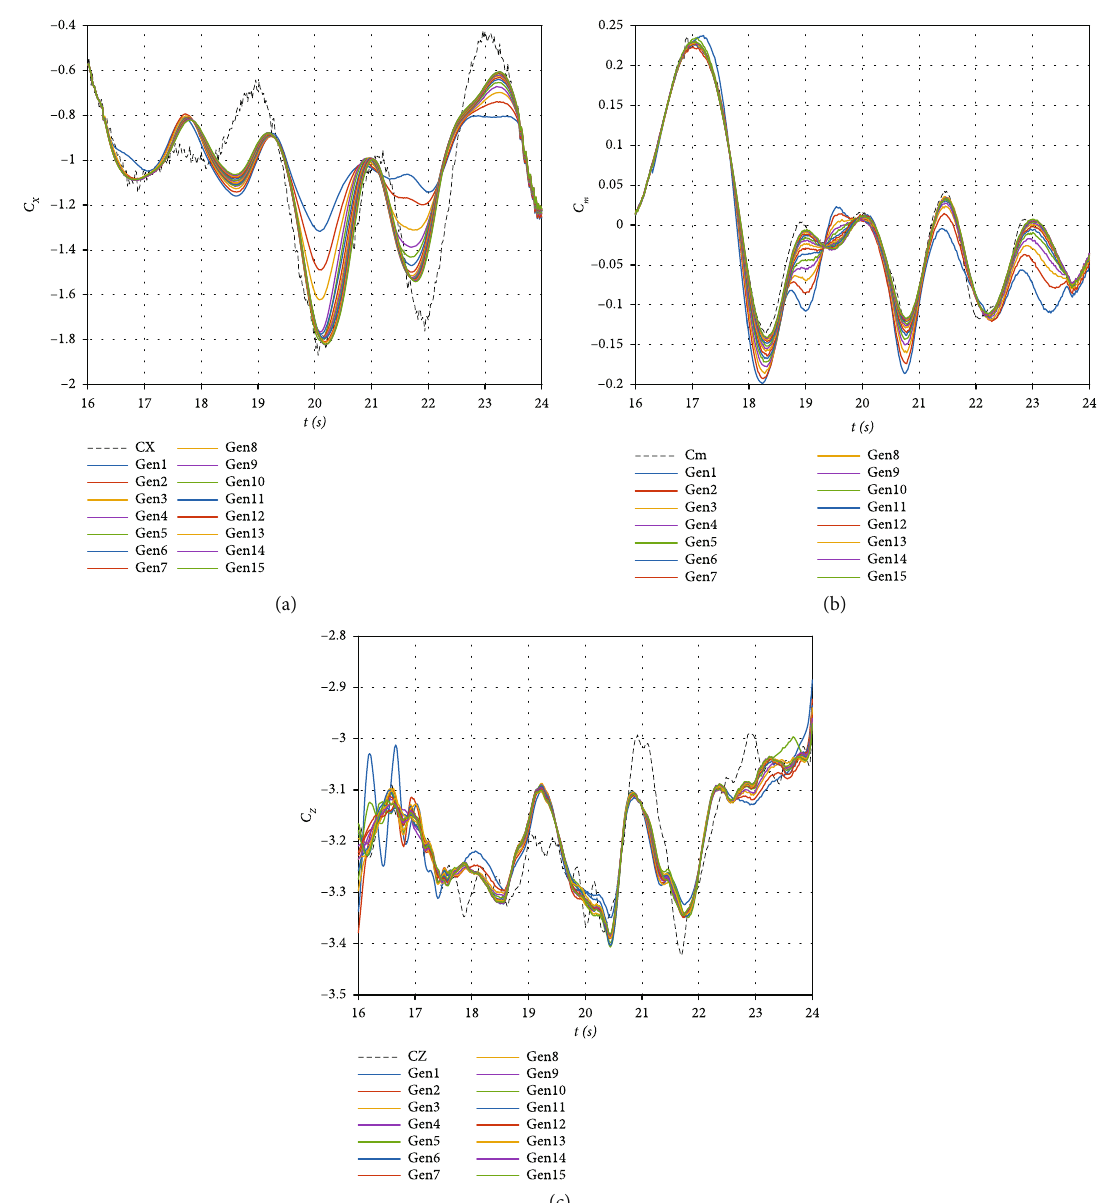
Figure 10: Results of the NSGA-II generation by generation: (a) C